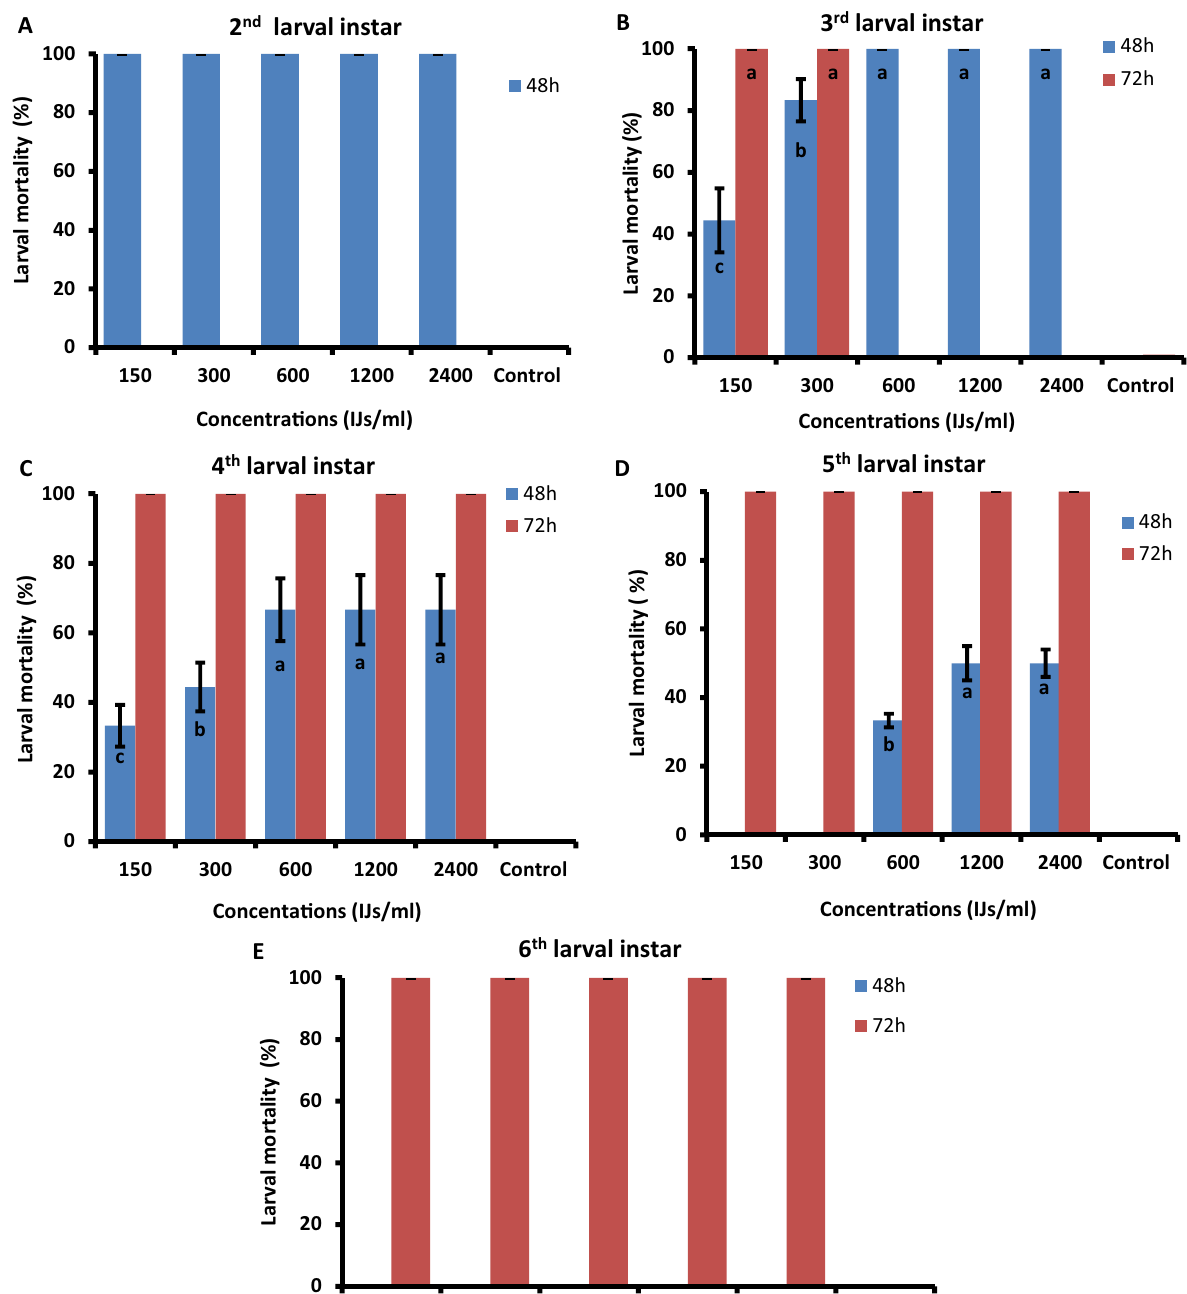
Fig. 1 Mortality percentages of different larval instars of Spodoptera frugiperda exposed to different infective juvenile nematode concentrations (IJs/ ml) of Steinernema carpocapsae . Columns shared with the same letters within the same instar are statistically insignificant ( P >